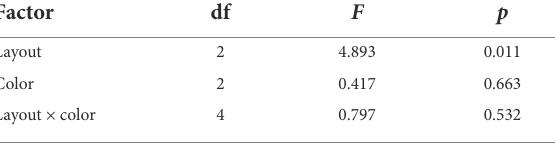
TABLE 11 Results of repeated measures ANOVA on fixation time.